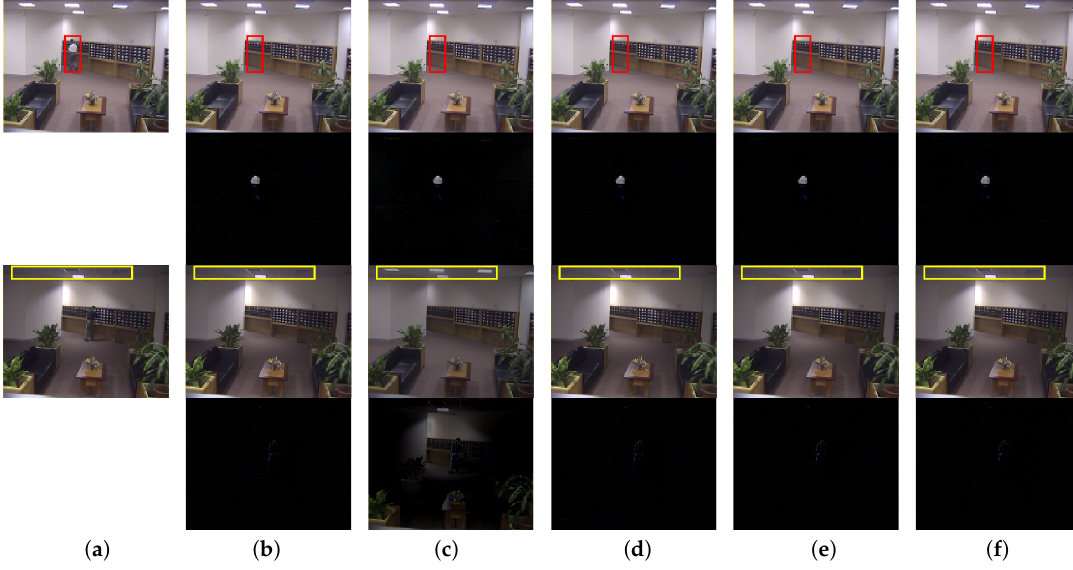
Figure 6. Background modeling: two example frames from Lobby sequences are shown. ( a ) Original; ( b ) RPCA [4]; ( c ) Gamma [26]; ( d ) SNN [49]; ( e ) TRPCA [20]; ( f )